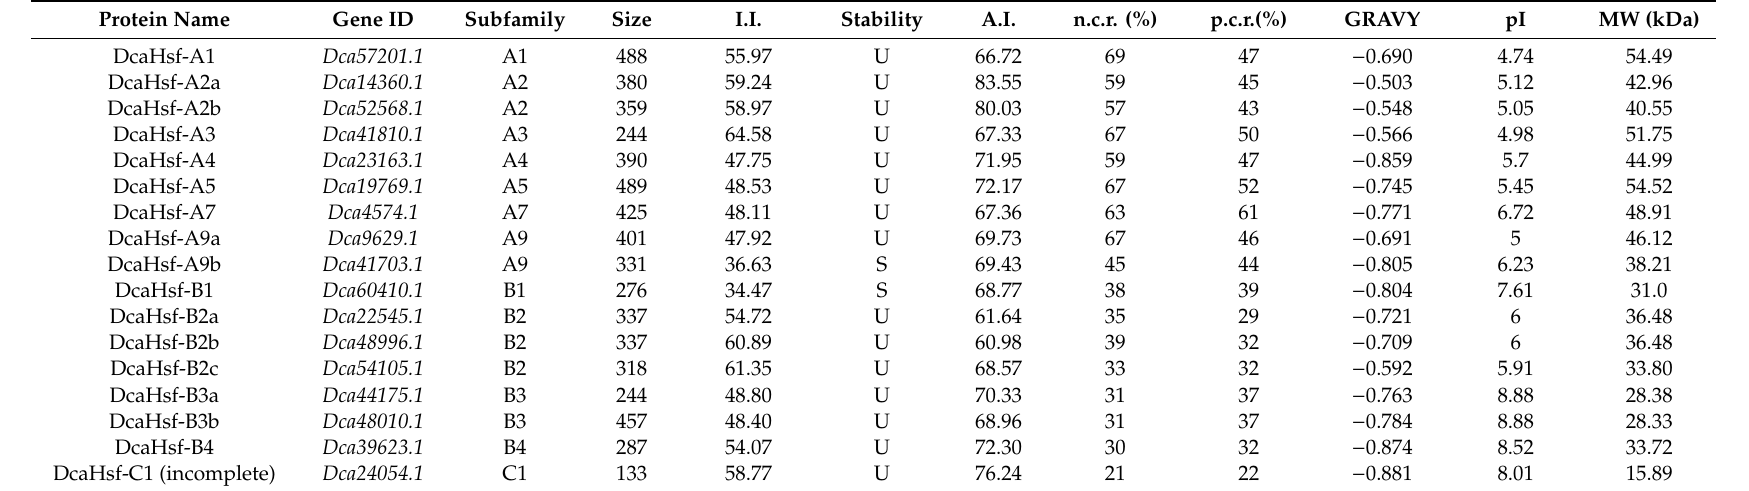
Table 1. Summary information of Dianthus caryophyllus heat shock transcription factors (DcaHsfs) in carnation. Notes: I.I., instability index; Stability, (U: unstable protein, S: stable protein); A.I., aliphatic index; n.c.r., total number of negatively charged residues (Asp + Glu); p.c.r., total number of positively charged residues (Arg